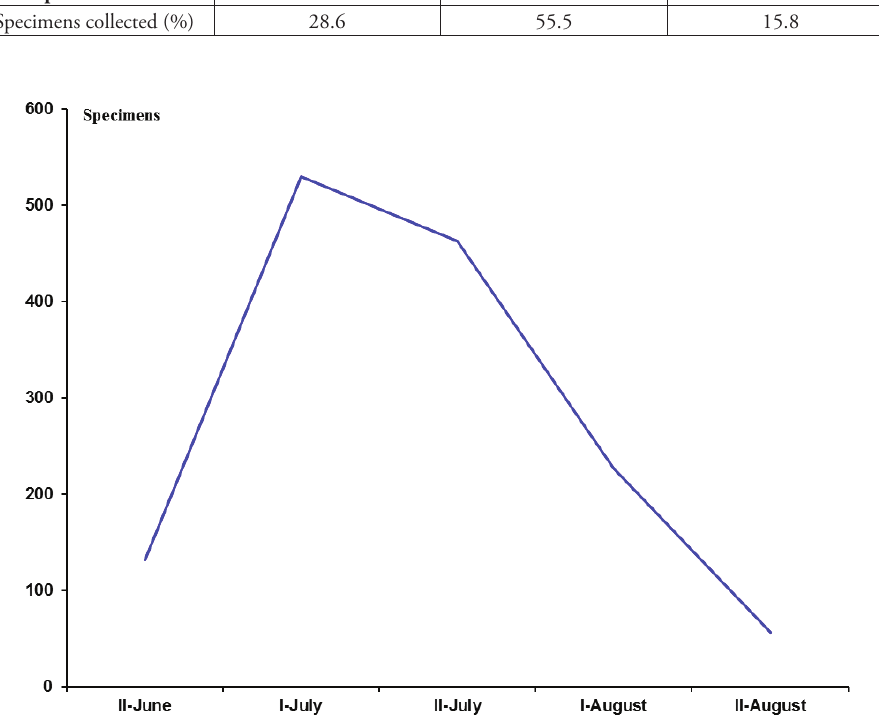
Figure 2. Flight period of Microgastrinae in the High Arctic. Number of specimens (as shown on Y axis) based on data from present paper. I First half of a month II Second half of a month.